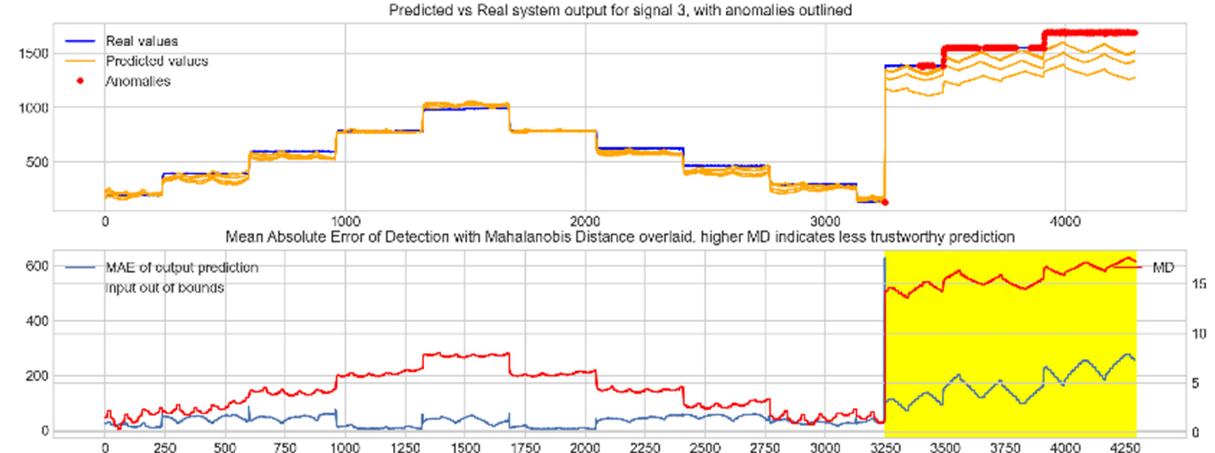
Figure 19. Bias fault inserted in input signal 3, the motor power, from data point 3250 onwards, with NN anomaly detection highlighted in red and inputs outside the expected input space shaded in yellow.